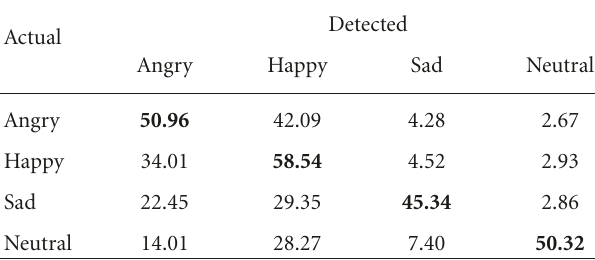
Table 8: Four emotions recognition rate (%) balanced speaker and text independent test-utterance based: 100 utterances per emotion, random sequence of speakers, SNR = 10